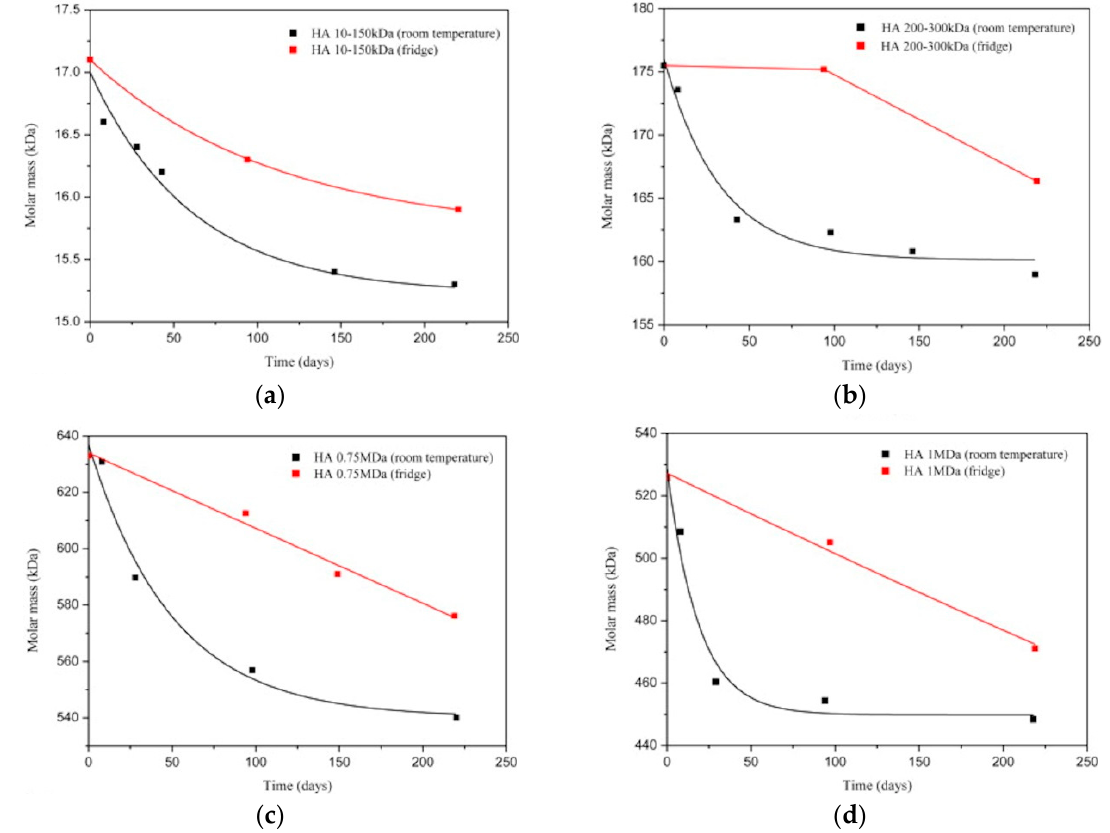
Figure 21. Degradation of HA samples with different MW: ( a ) 17 kDa, ( b ) 267 kDa, ( c ) 752 kDa, ( d ) 1000 kDa. Reproduced from [126], with permission from Elsevier, 2020.